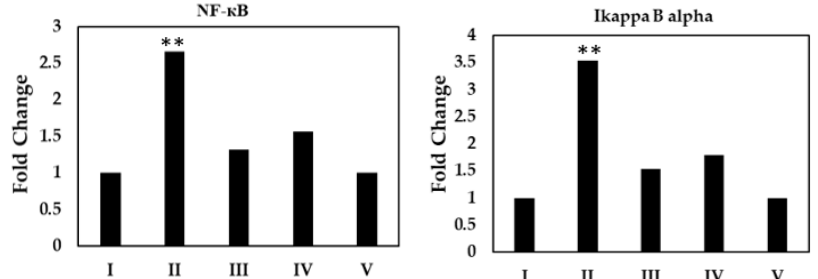
Figure 9. Immunoblot analysis of the inhibition of I κ B α and NF-KB in xenografted whole mice tumors. ** p < 0.001 as compared to controls.